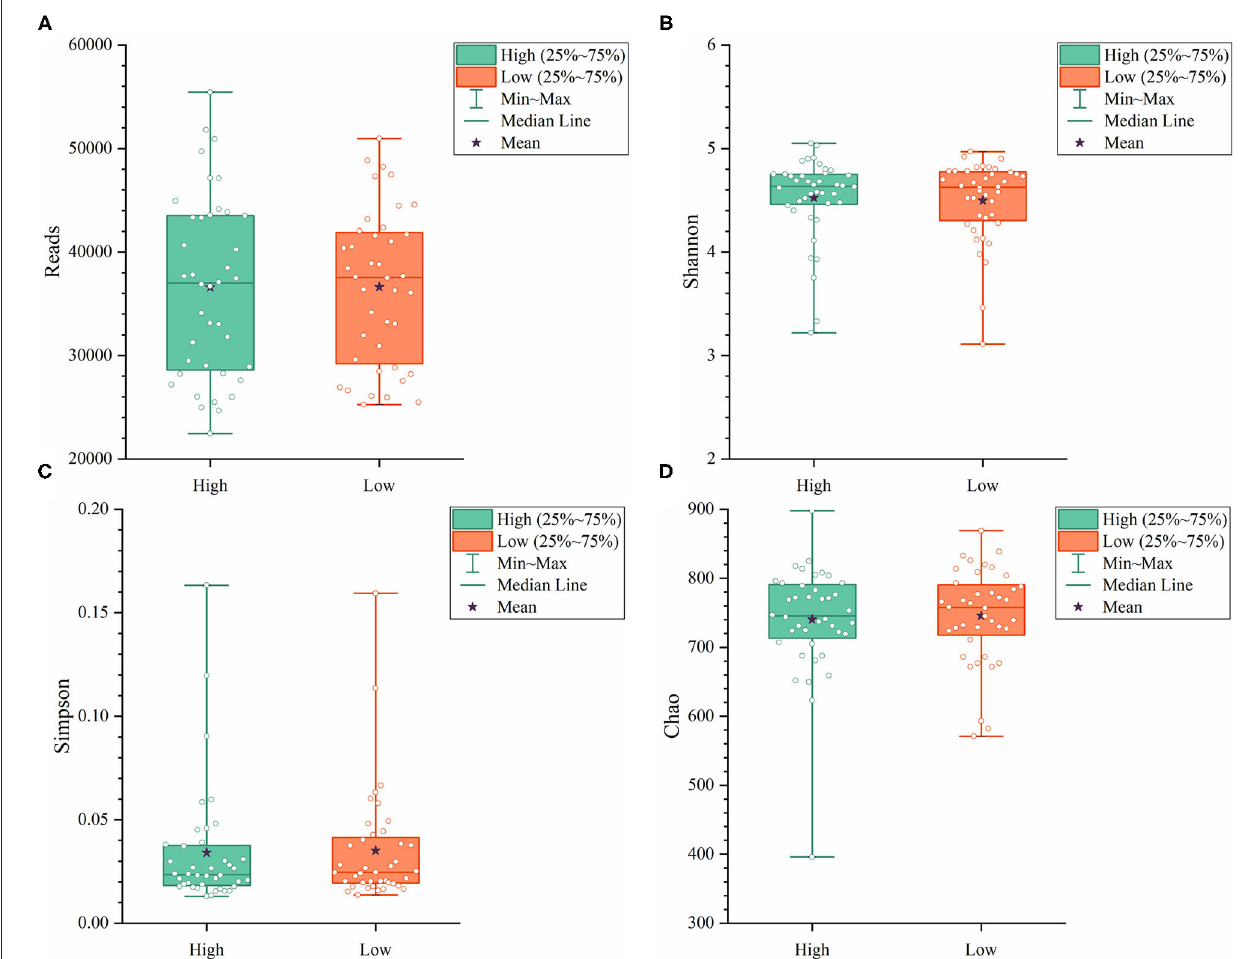
FIGURE 4 | The α -diversity including Reads (A) , Shannon (B) , Simpson (C) , and Chao (D) in the cecum of high and low group ducks.